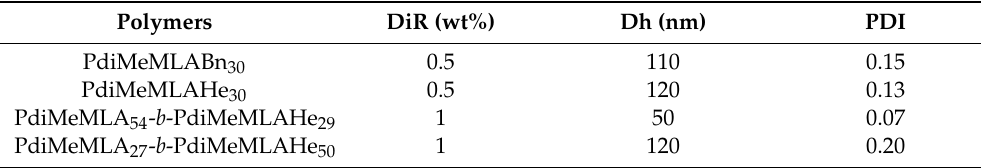
Table 6. Characteristics of DiR-loaded NPs suspensions.